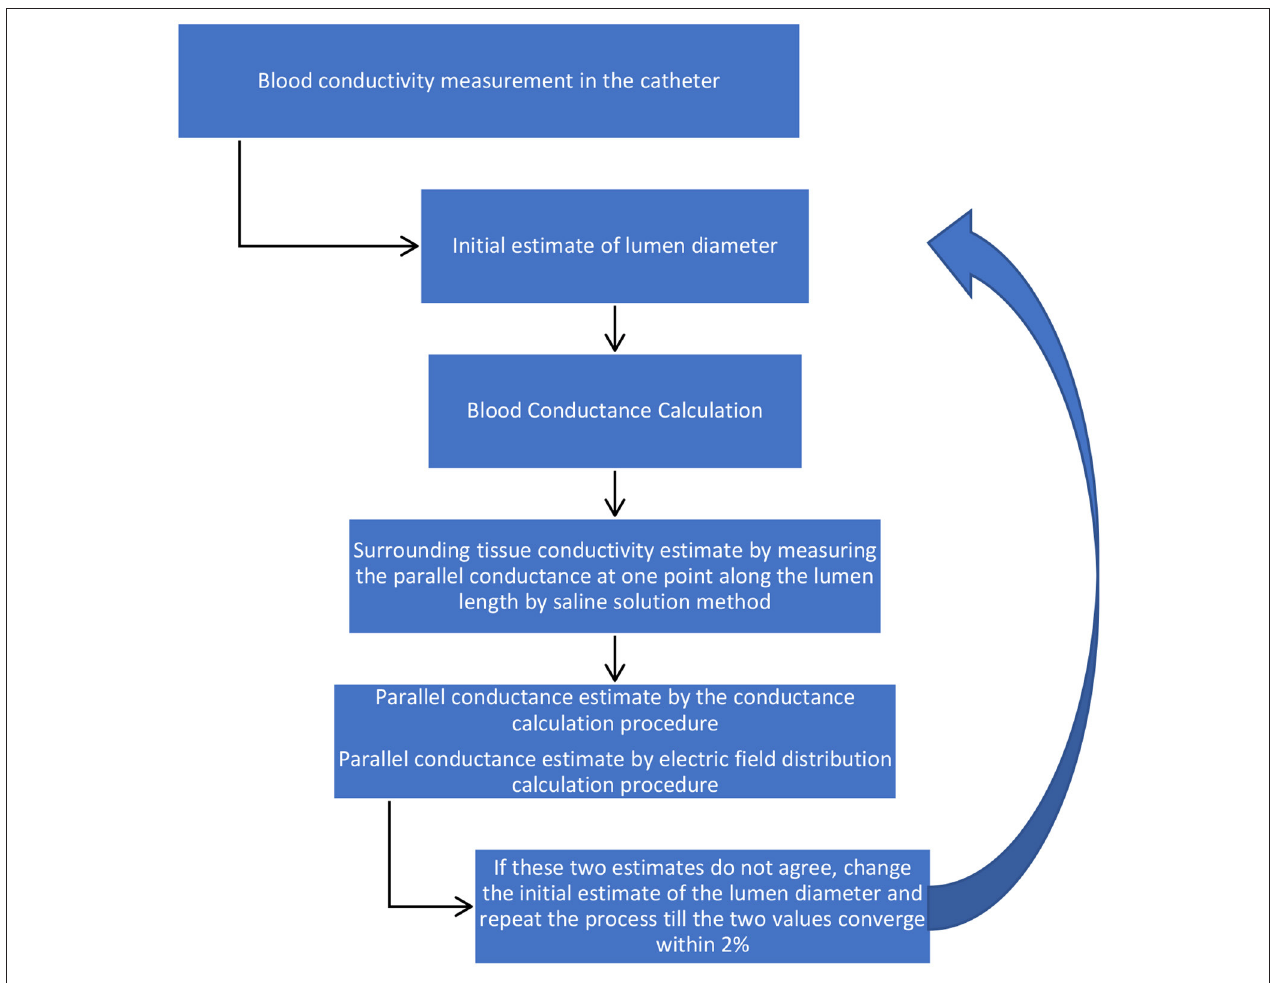
FIGURE 1 | Injection-less method for pull back procedure.